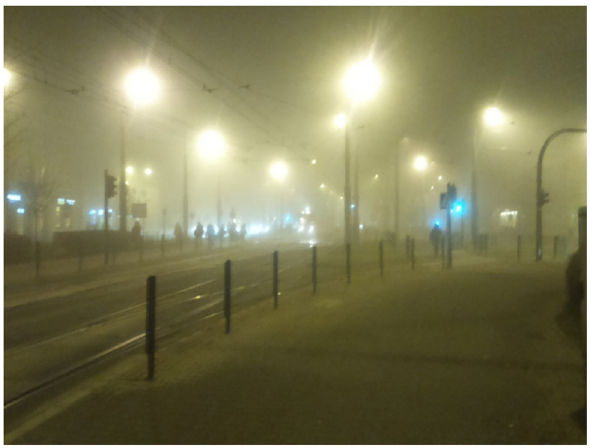
Figure 1: Dietla street in Krakow, during the smog. Source: